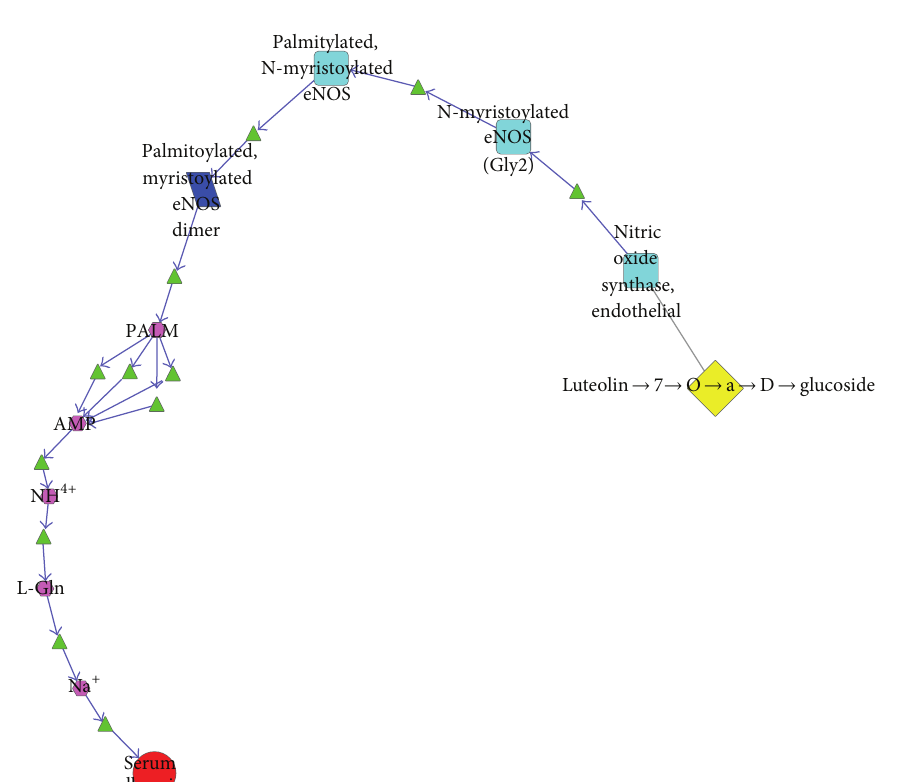
Figure 6: The antipneumonia biological pathway of luteolin-7-o- 𝛼 -D-glucoside.